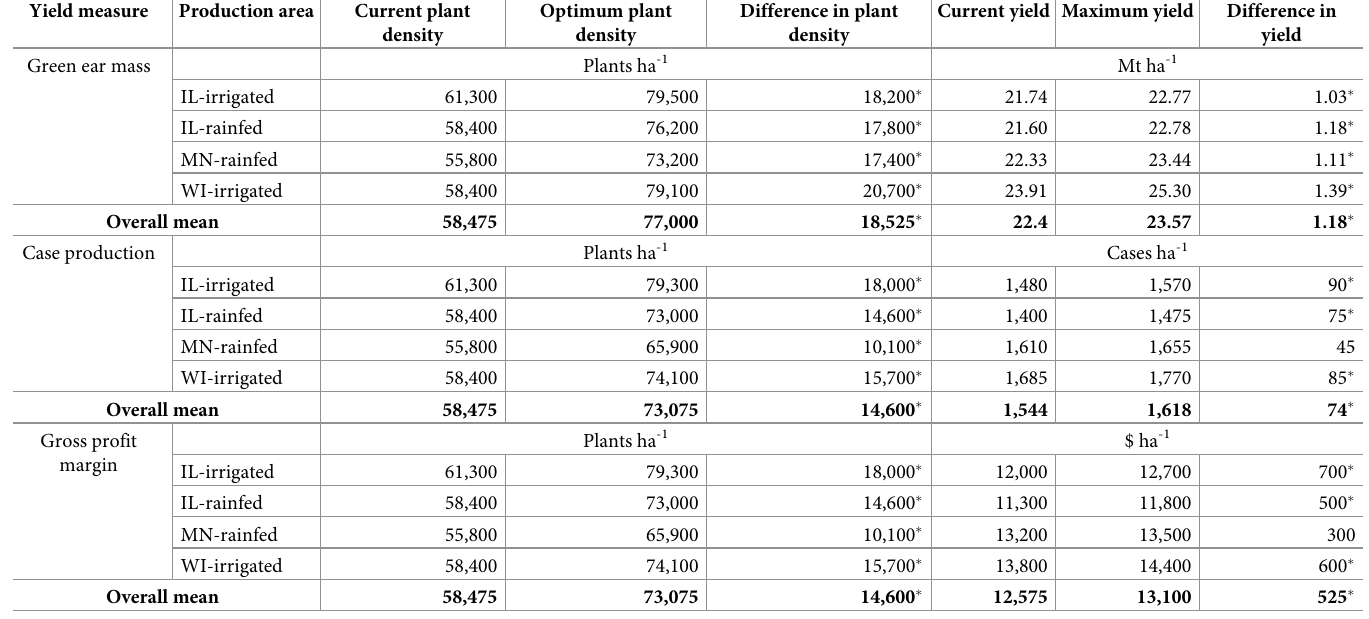
Asterisks represent significant differences between values at current and maximum at α = 0.05 based on pairwise